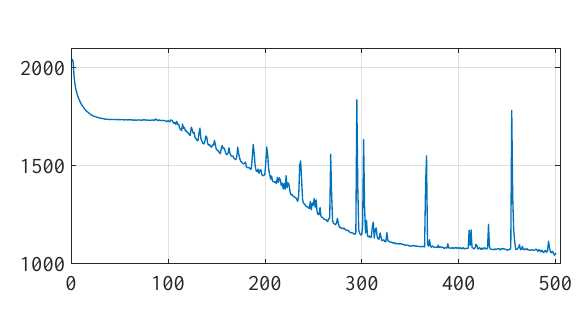
Figure 6. Neural network training